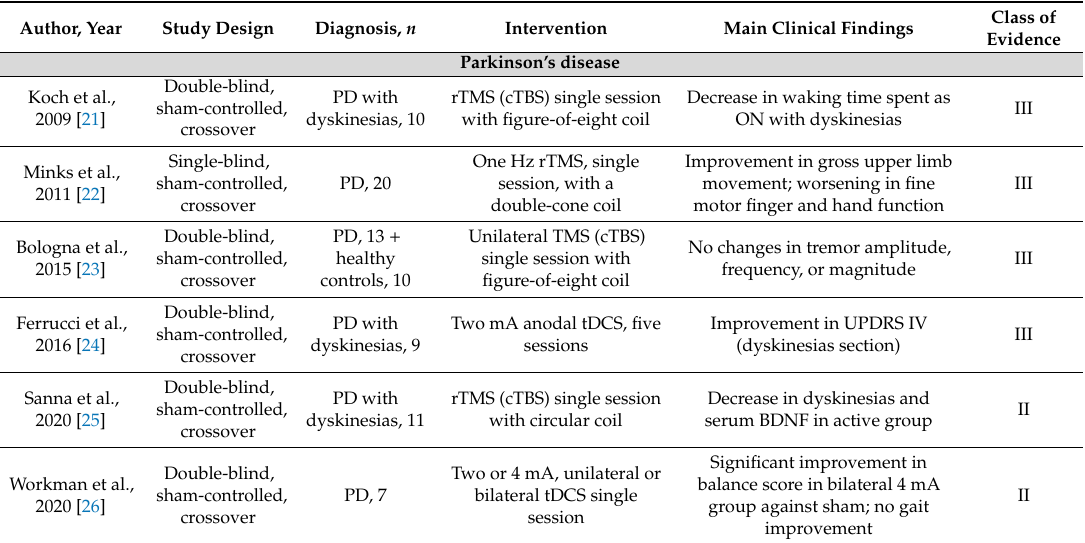
Table 1. Clinical trials of cerebellar neuromodulation for Parkinson’s disease, dystonia, cerebellar ataxia, and essential